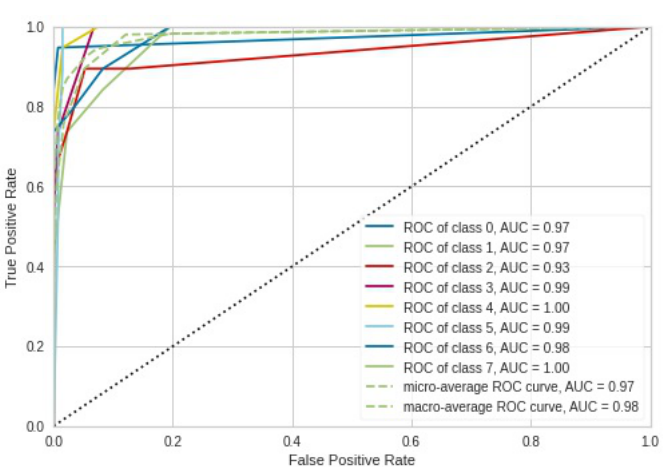
Figure 8. ROC AUC Curves for kNN model-based